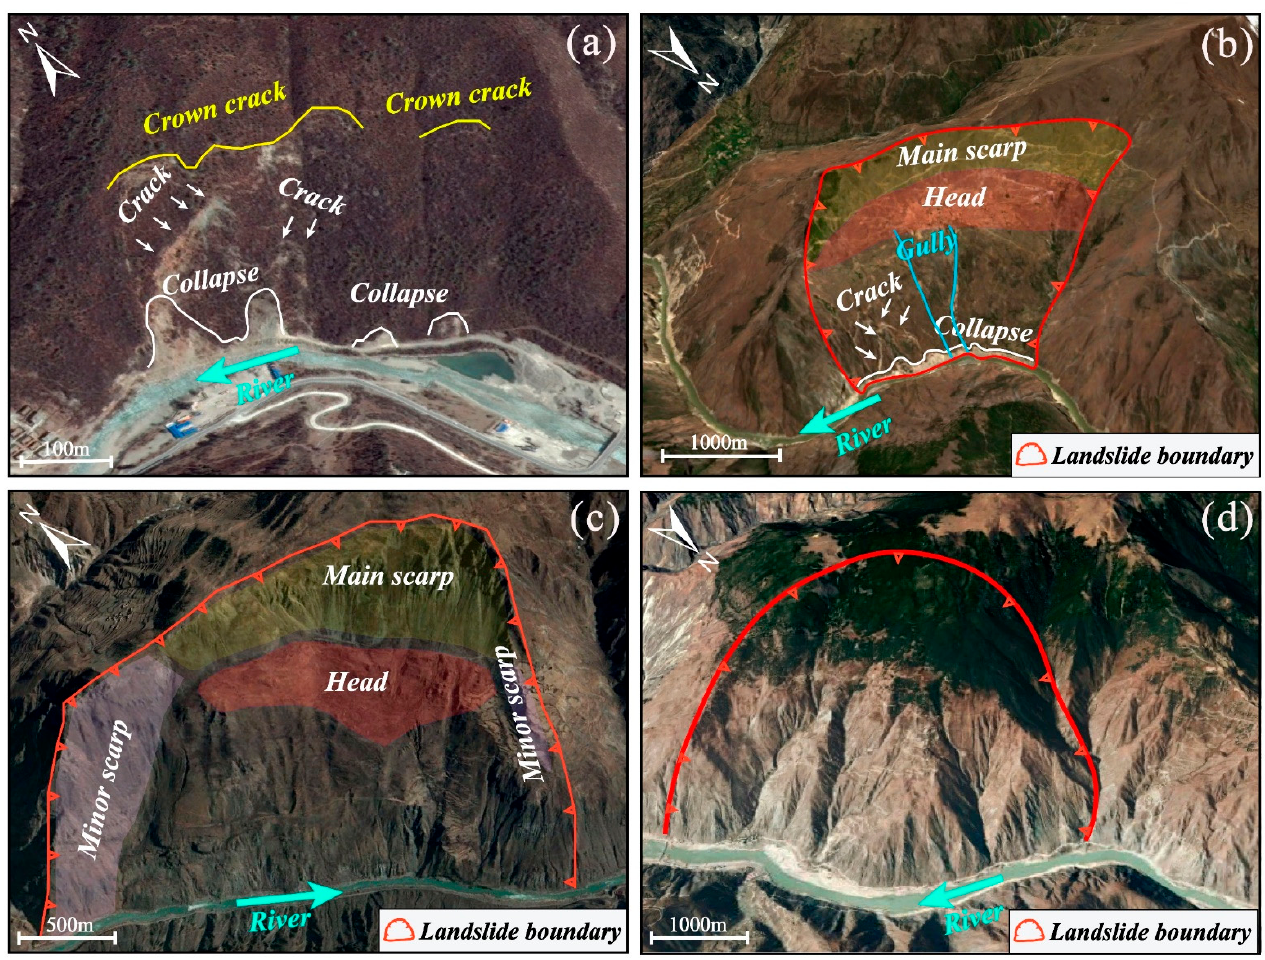
Figure 3. Examples of landslides with different types: ( a ) actively deforming slope (I), ( b ) reactivated historically deformed slope (II), ( c ) stabilized historically deformed slope (III), and ( d ) undeformed but potentially unstable slope (IV).